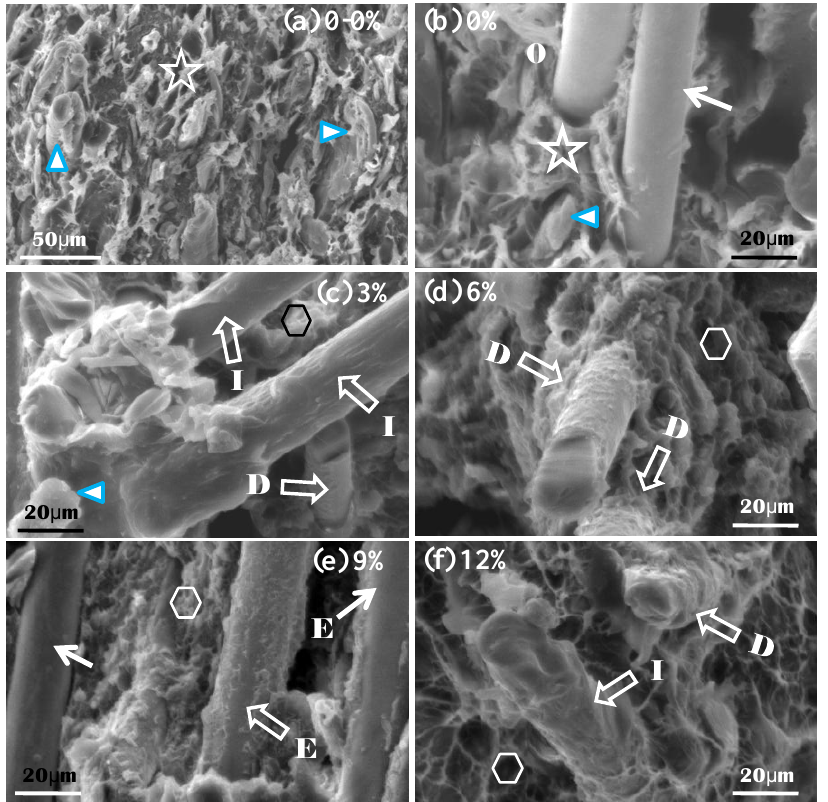
Figure 2. SEM micrographs of the tensile fracture surfaces of the composite: ( a ) pure WPC; ( b – f ) the WPC with the corresponding mass fractions of MAPE shown in each picture. The symbol “0” and the capital letters identify the interface mode; triangles: wood fibers, stars: HDPE; 0: the lack of an interfacial layer (IL), E: partial IL, D: wave-like IL, I: flat IL; arrows: smooth BF surface, wide arrow: ILs; hexagon: soft and dense